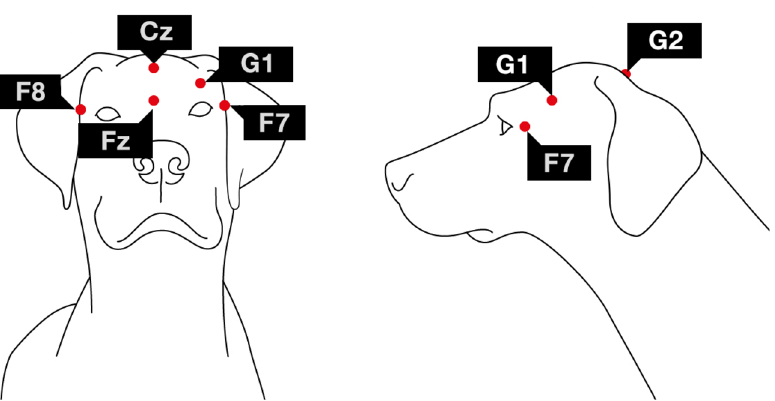
Figure 1. Placement of the electrodes (Fz-Cz: frontal and central midline; F8 and F7: right and left electrodes placed on the zygomatic arch; G2: reference electrode; G1: ground electrode). EEG traces of different sleep stages and a wake period is included in our Supplementary document (Fig.